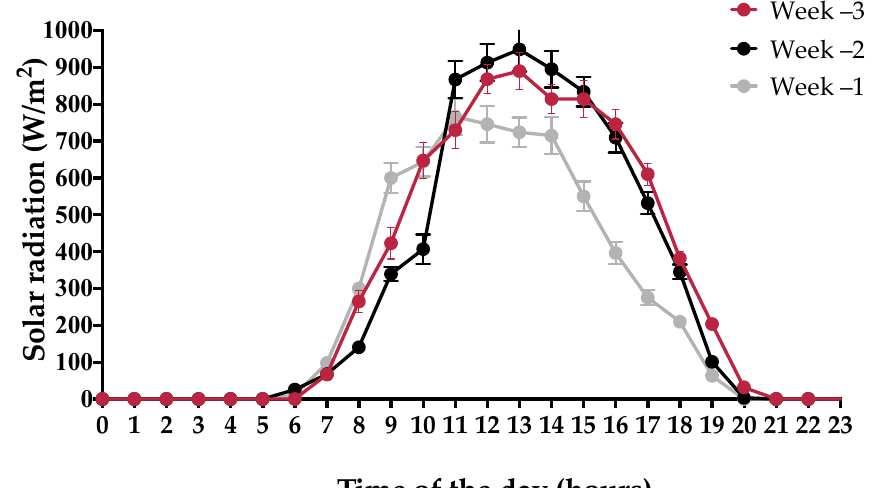
Figure 2. Mean (± SE) hourly solar radiation in different weeks prior to calving.